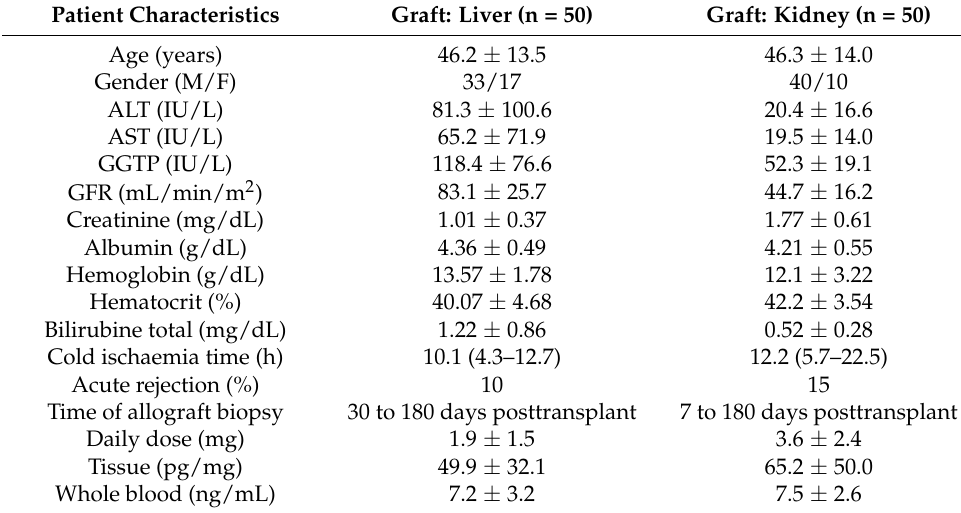
Table 2. Summary of demographic and clinical